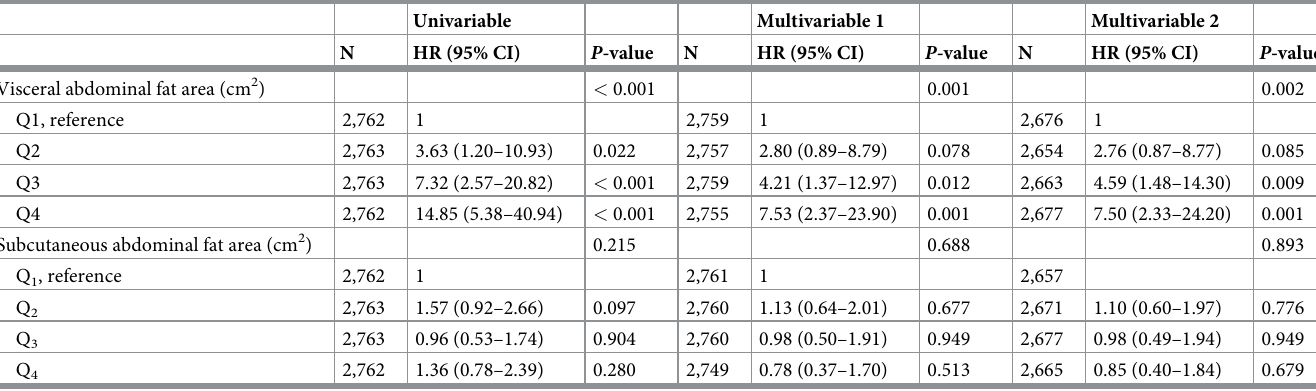
Table 2. The risk of chronic kidney disease in relation to the abdominal adipose tissue area. Univariable Multivariable 1 Multivariable